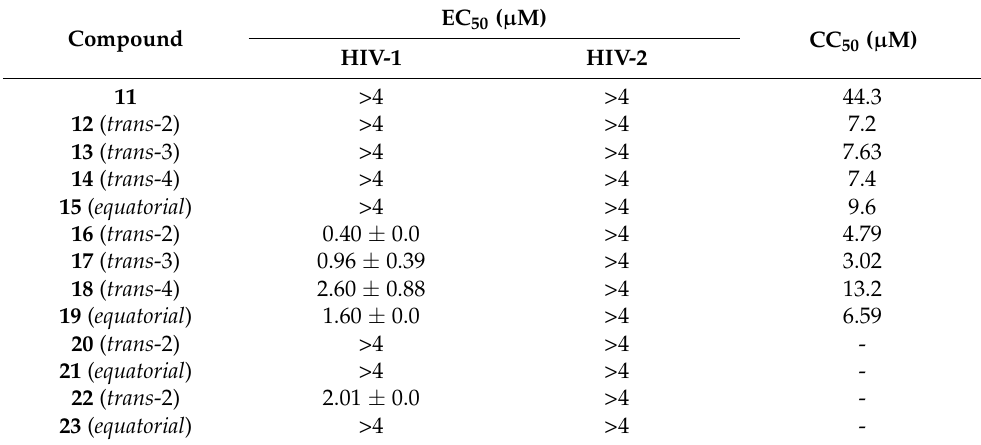
Table 1. Anti-HIV activity and cytostatic toxicity of compounds ( 11 – 23 ) in CEM cell